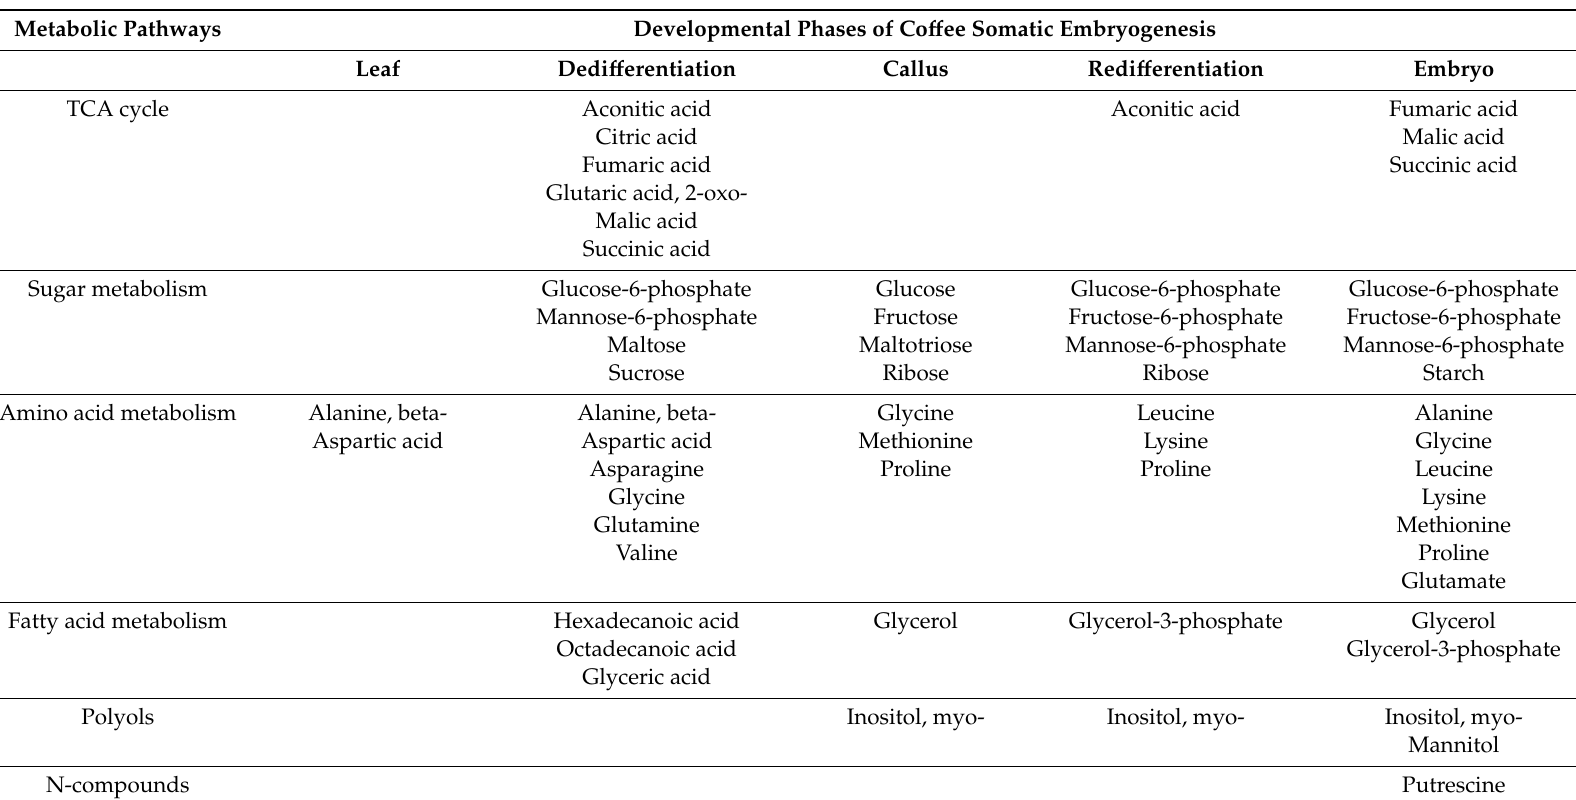
Table 2. Significantly over-accumulated metabolites in the five developmental phases forming the Arabica SE